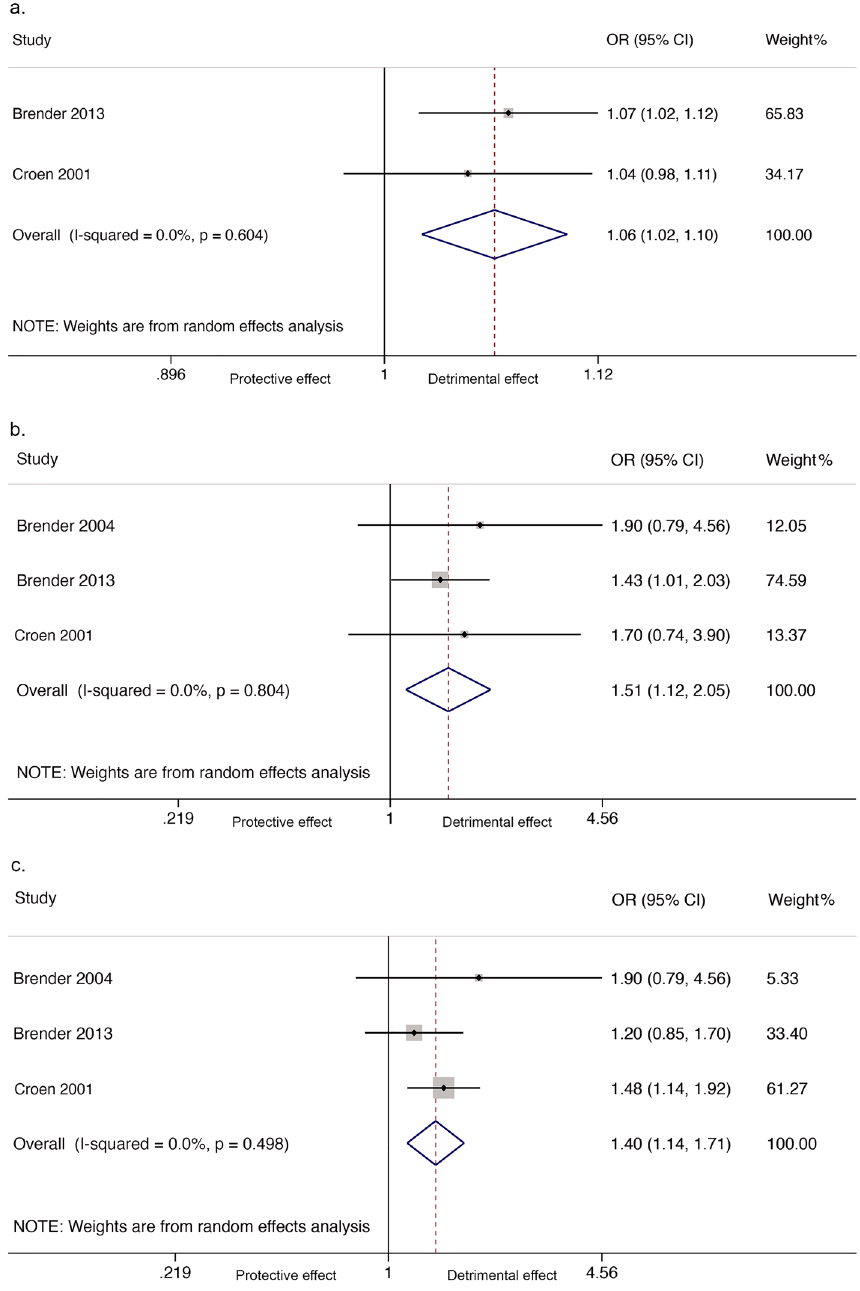
Figure 4. Forest plot for the association between nitrate in drinking water and neural tube defects. ( a ) Linear relationship; ( b ) Highest versus the lowest exposure; ( c ) All combined higher versus the lowest exposure